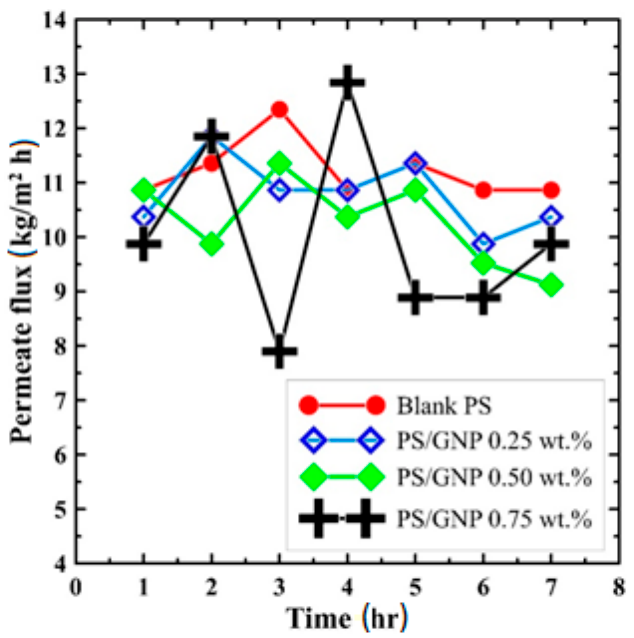
Figure 6. Comparison of permeate flux for all fabricated membranes over 7 h operating time.